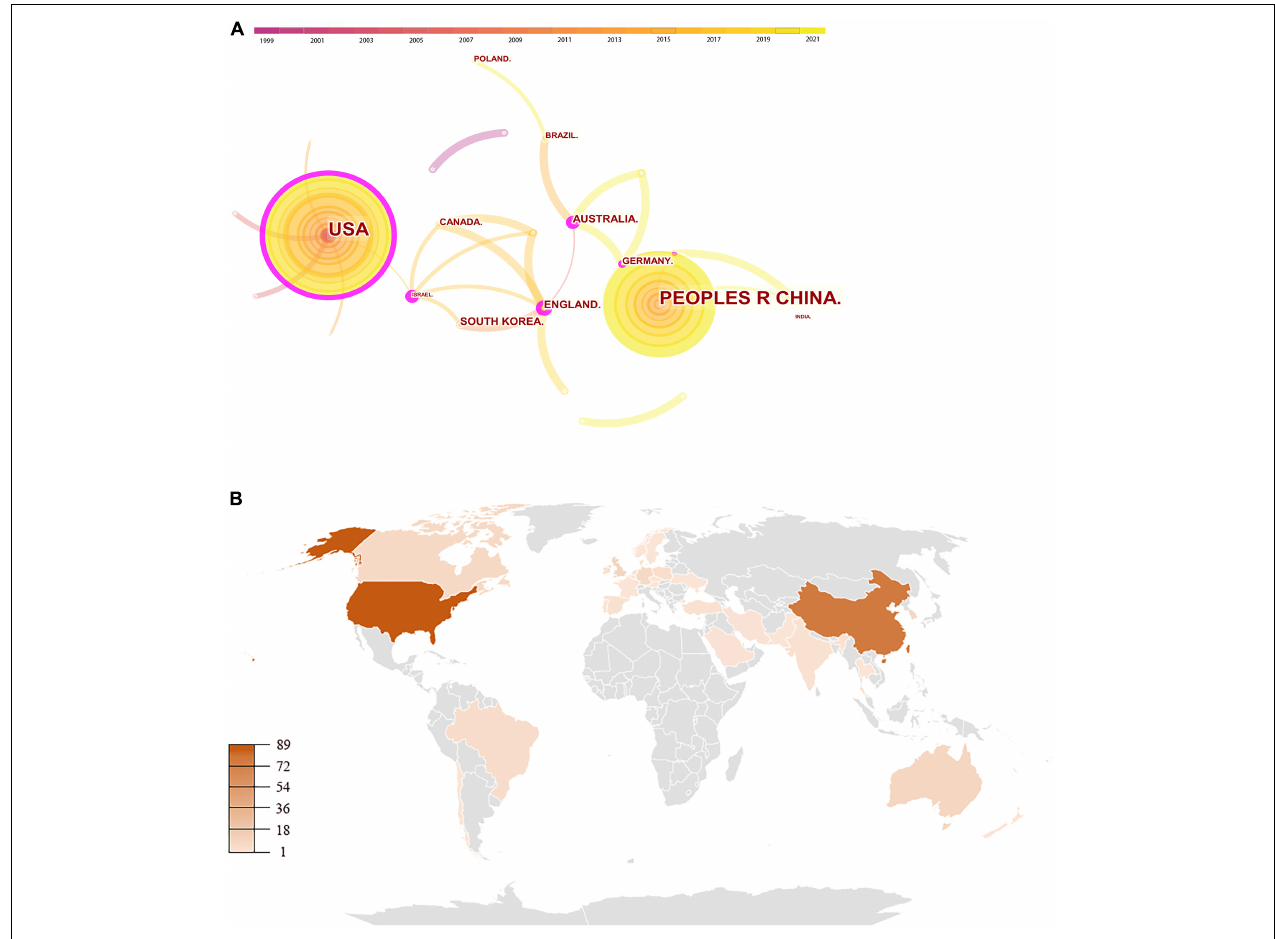
FIGURE 2 | Visualization of countries/regions. (A) Collaboration network of countries/regions. The nodes in the map represent countries. The lines between the nodes represent cooperation relationships. The size of the node area shows the number of co-citations. The colors in the nodes represent the years. The purple ring represents centrality. (B) World map of publications distributed in various countries/regions.